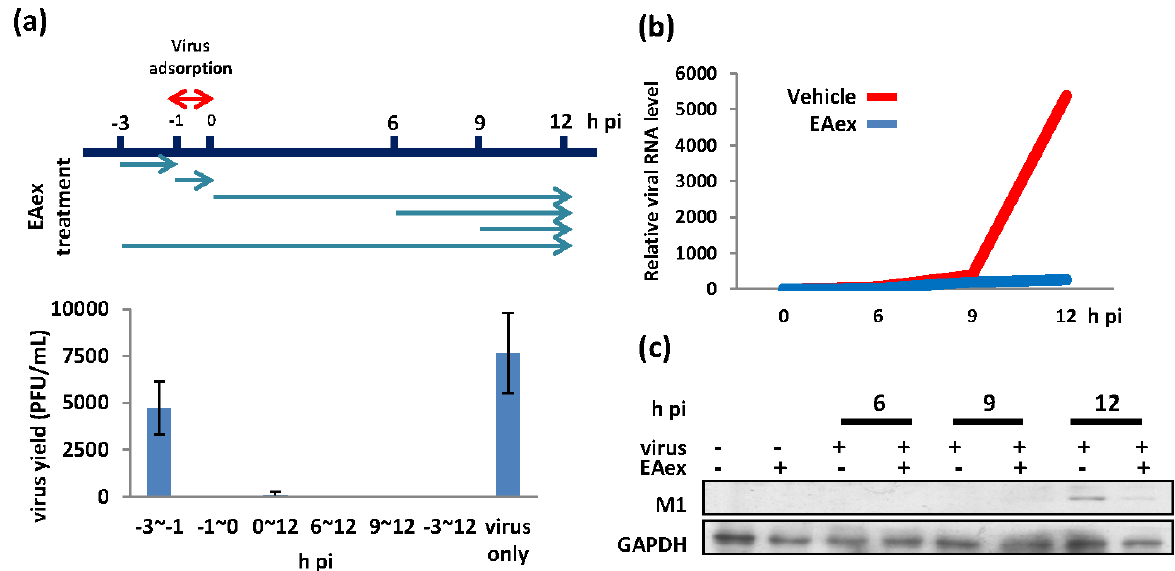
Figure 1. Determining the mode of action of EAex by ( a ) time-of-addition assay, and inhibition of ( b ) viral RNA and ( c ) protein production. MDCK cells were infected with influenza A/WSN/33 (MOI: 0.01) with 0.025 mg/mL of EAex added at the indicated time points. For RNA and protein experiments, 0.025 mg/mL of EAex was added after virus absorption. Viral M1 was normalized with GAPDH in both ( b ) RNA and ( c ) protein level, with or without